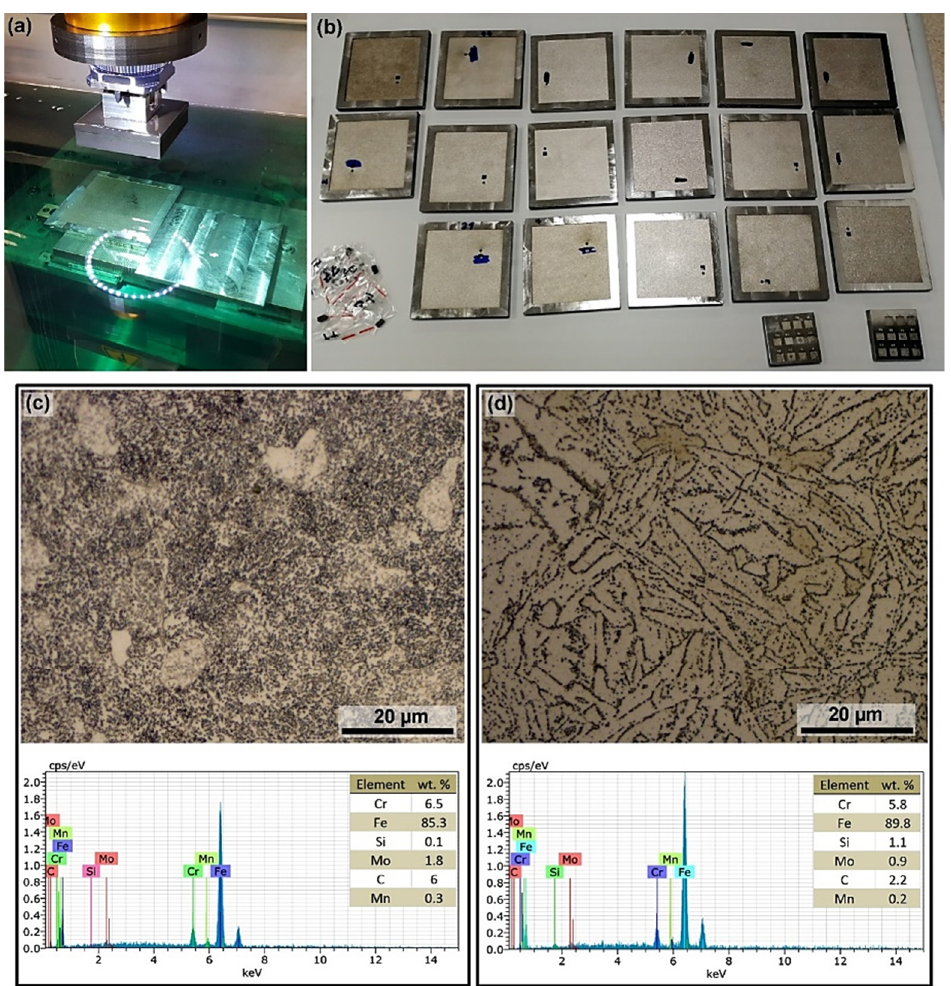
Figure 1. ( a ) Eroding process, ( b ) samples produced, ( c ) microstructure representation and chemical composition analysis of 1.2363 steel, ( d ) microstructure representation and chemical composition analysis of 1.2343ESR steel.